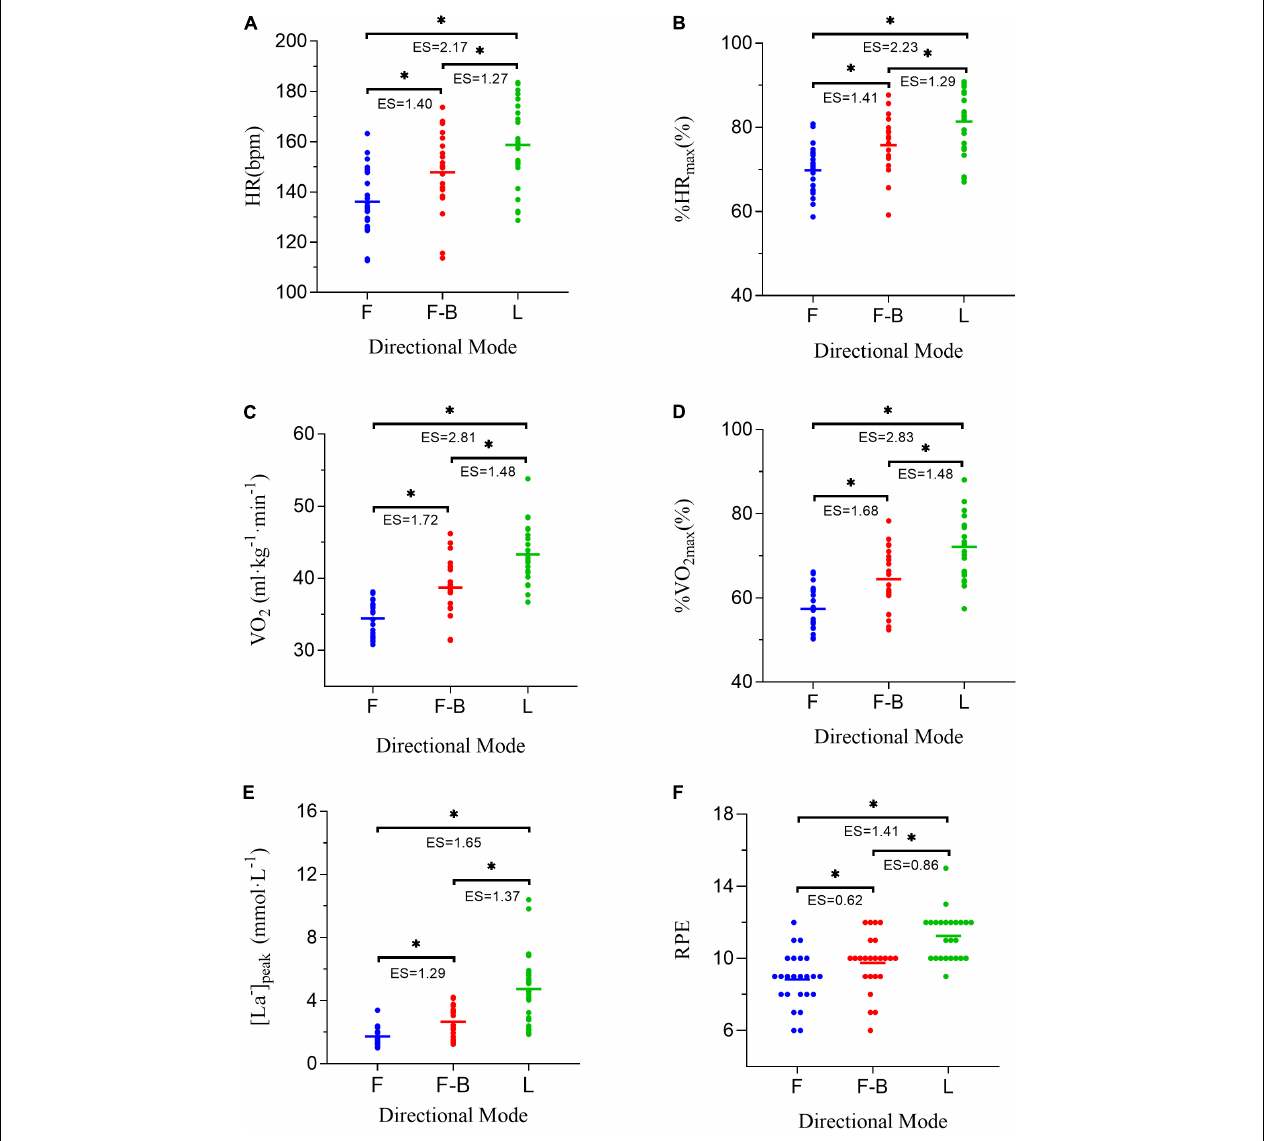
FIGURE 1 | Physiological and perceptional responses to three modes of shuttle running: HR (A) , %HR max (B) , VO 2 (C) , %VO 2max (D) , [La − ] peak (E) , RPE (F) . HR, heart rate; HRmax, maximal heart rate; %HR max , the ratio of HR to HR max in percentage; VO 2 , oxygen uptake; VO 2max , maximal oxygen uptake; %VO 2max , the ratio of VO 2 to VO 2max in percentage; [La − ] peak , the peak value of blood lactate concentration; RPE, rating of perceived exertion; F, forward shuttle running, F-B, forward-backward shuttle running; L, lateral shuttle running; ES, effect size. *Statistically significant difference ( p <